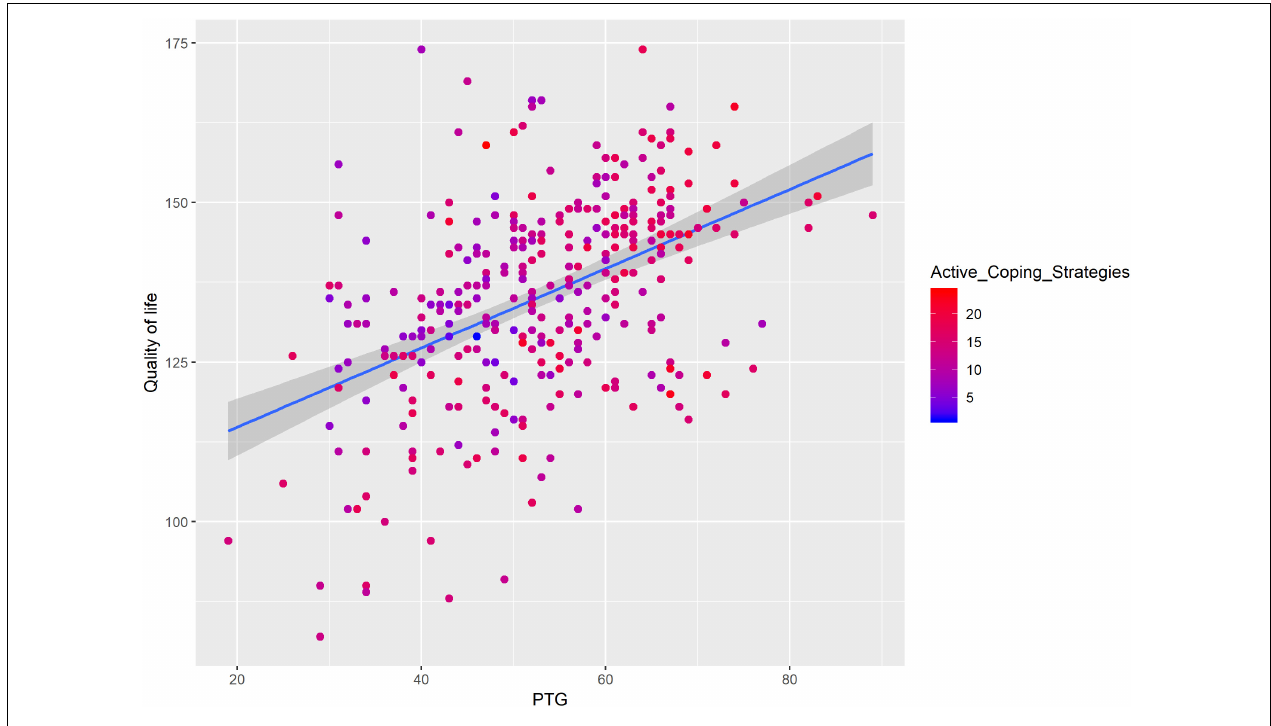
FIGURE 4 | The moderating effect of active coping on the relationship between PTG and QoL.